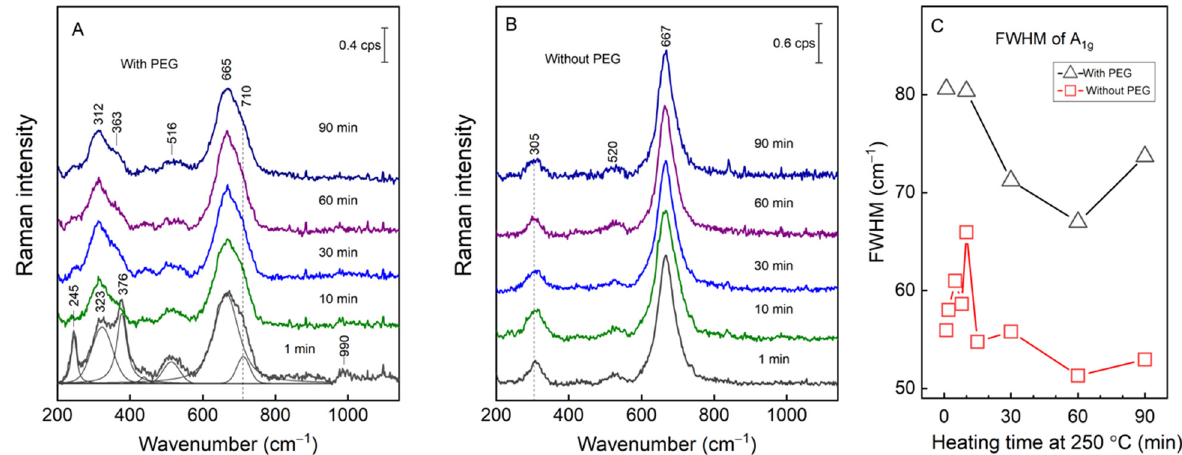
Figure 4. Raman spectra of the samples prepared with ( A ) and without ( B ) PEG heated from 90 to 1 min. The dependence of the full width at half maximum (FWHM) of the A 1g mode on the MPs preparation time at 250 °C with (black triangles) and without (red squares) PEG ( C ). The excitation wavelength was 830 nm; the laser power was set to 0.8 mW; the acquisition time was 60–120 min.